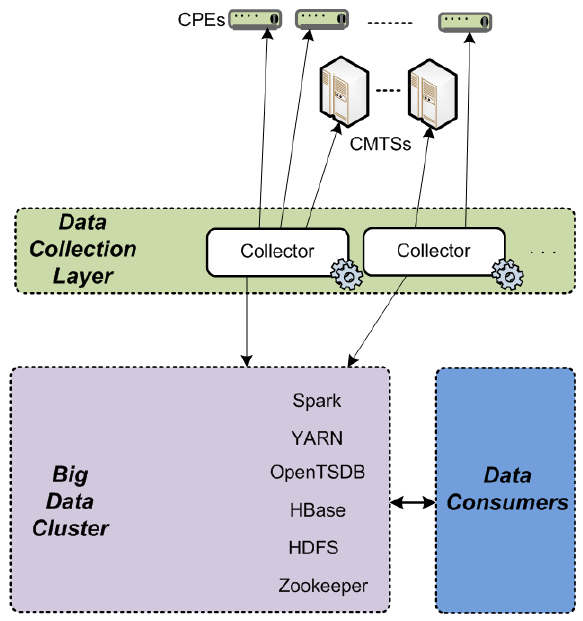
Figure 2. Big data platform.